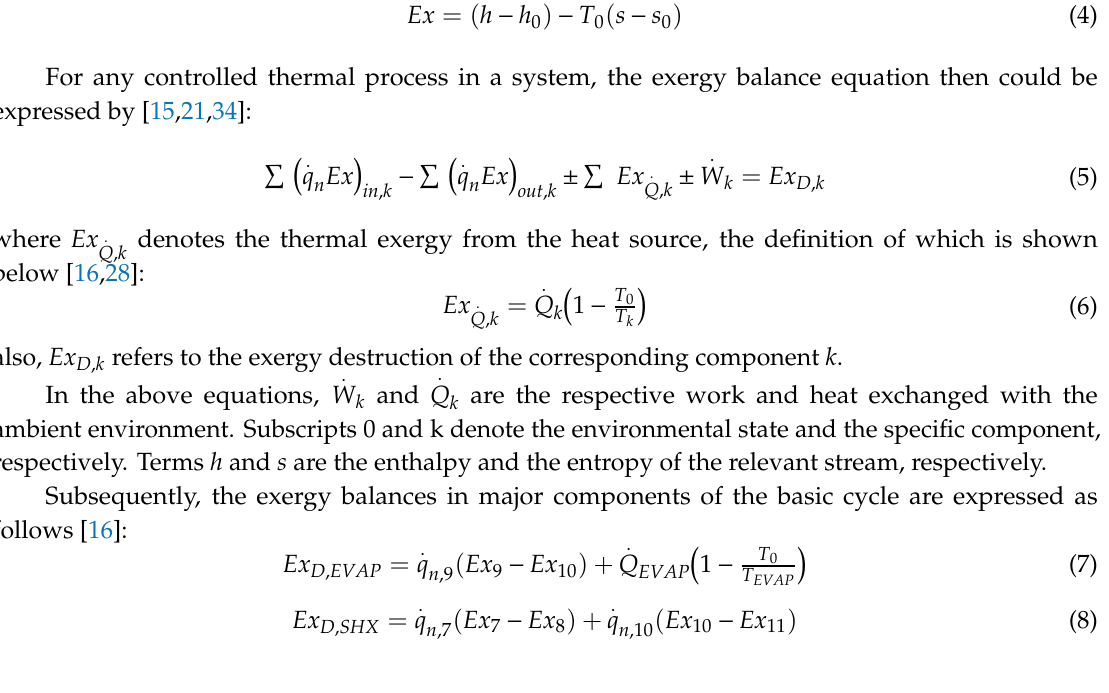
Table 4. Comparison of heat duties and coefficient of performance (COP) between experimental and simulation results at the ambient temperature of 35 °C.